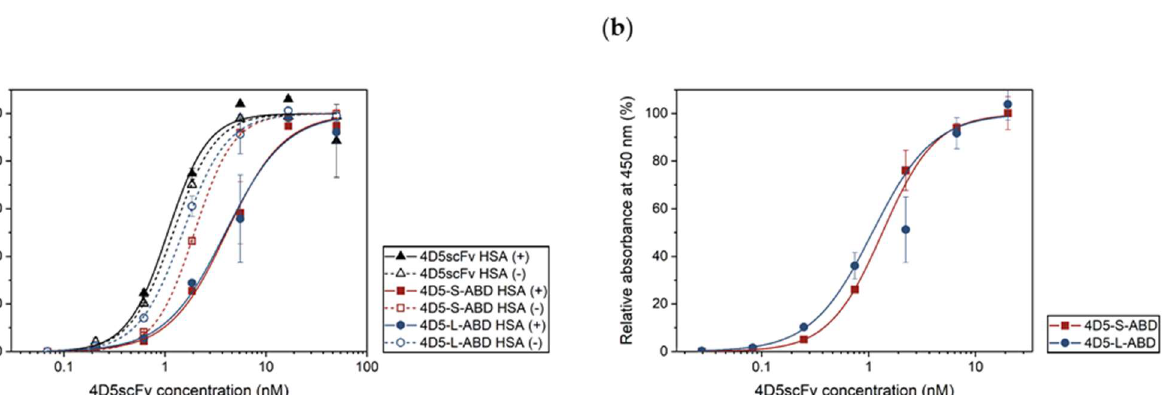
Figure 3. MALDI-TOF analysis of purified 4D5scFv and two 4D5-ABD variants.